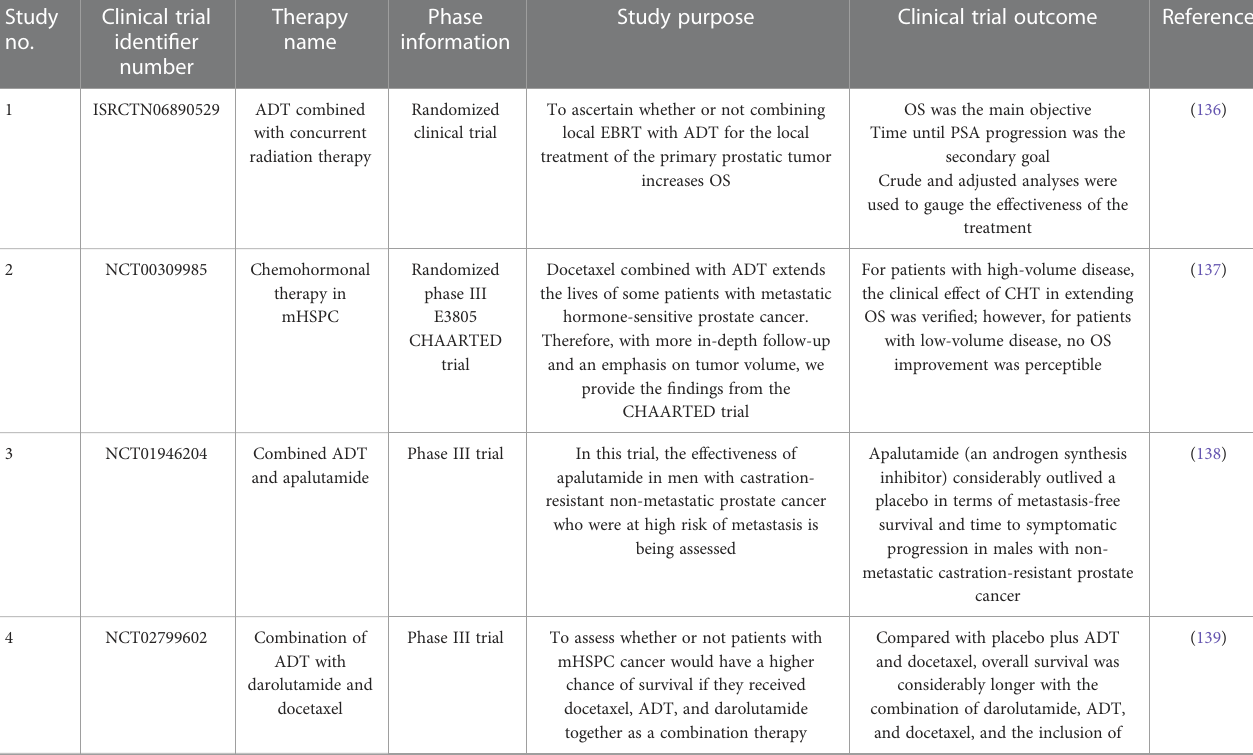
TABLE 2 Current clinical trials on combination therapies. Study